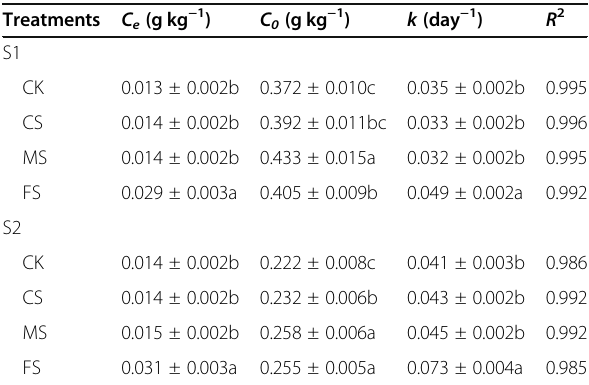
Table 2 Estimated parameters for measuring the easily mineralizable C pool ( C e ), potentially mineralizable carbon ( C 0 ) and decomposition rate constant ( k ), and determination coefficients ( R 2 ) using the first-order model of the cumulative soil CO 2 emission Treatments C e (g kg − 1